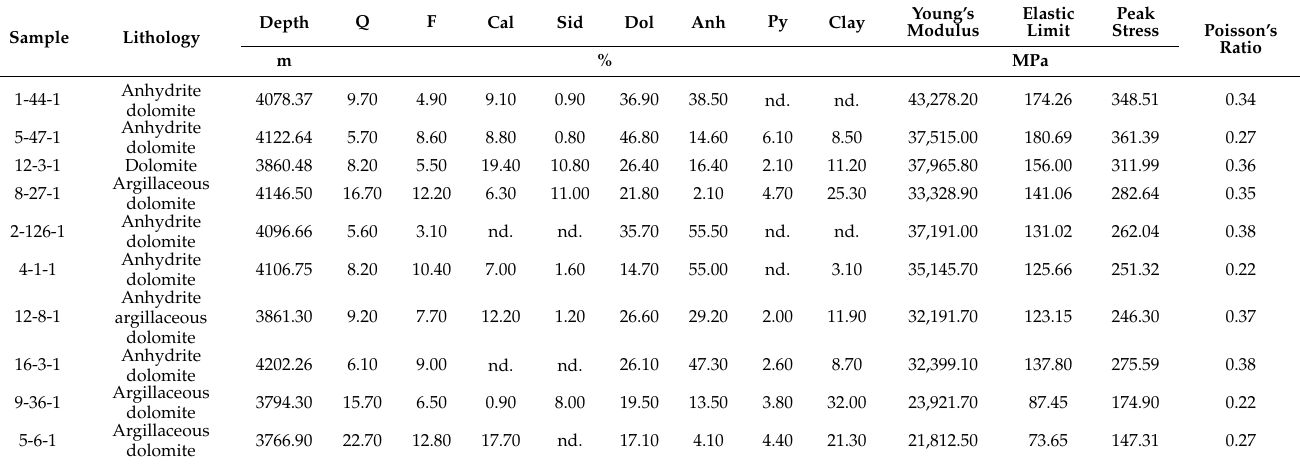
Table 3. Mineral composition and triaxial experiment results of